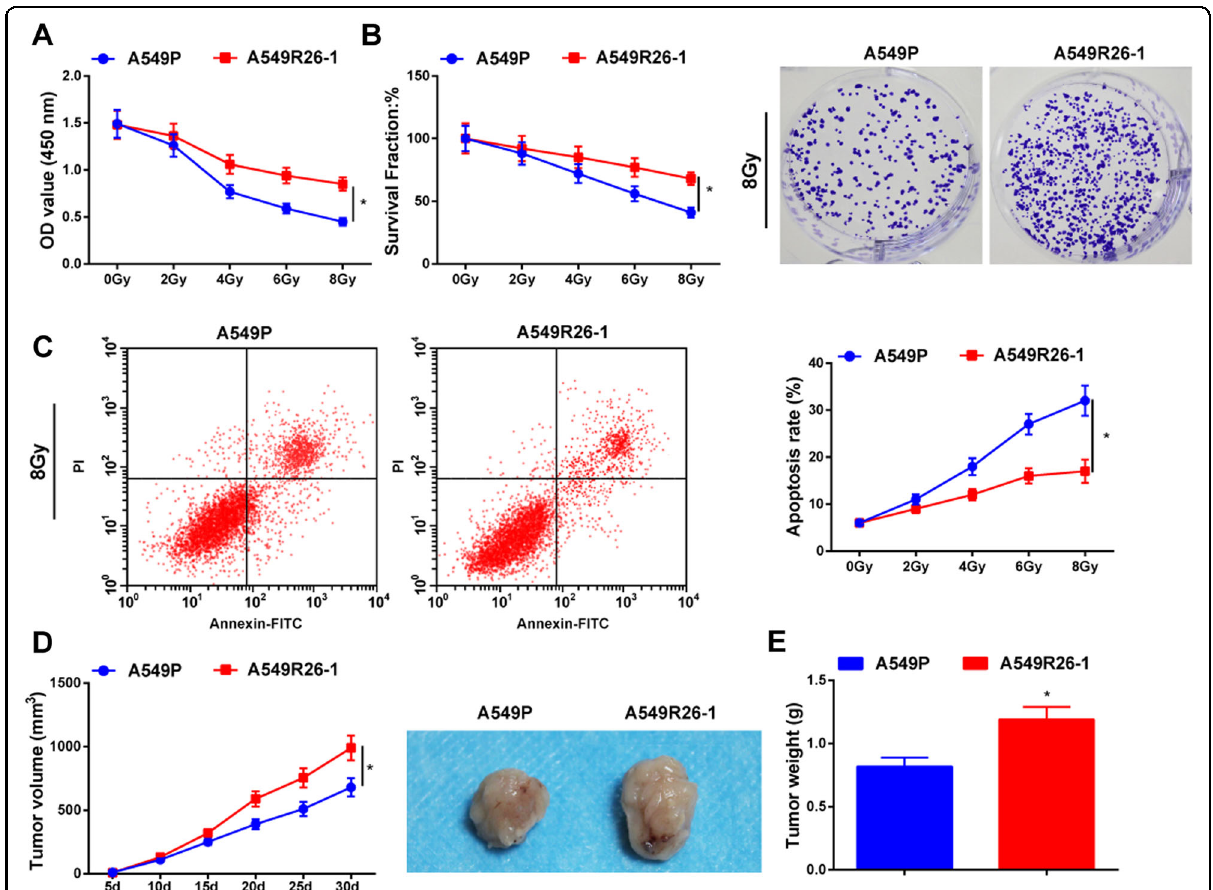
Fig. 2 Radioresistant lung cancer cells have stronger radioresistance ability than parent cells. A Viability of radioresistant lung cancer cells A549R26-1 and parental cells A549P was determined by CCK-8 assay. B Colony formation ability of radioresistant lung cancer cells A549R26-1 and parental cells A549P was detected by colony formation assay. C Apoptosis of radioresistant lung cancer cells A549R26-1 and parent cells A549P was detected by fl ow cytometry. D Volume of xenografts from nude mice that had been injected with radioresistant lung cancer cells A549R26-1 and parental cells A549P. E Weight of xenografts from nude mice that had been injected with radioresistant lung cancer cells A549R26-1 and parental cells A549P; N = 3 in the cellular experiment and n = 6 in the animal experiment; * P < 0.05 vs. A549P cells; the measurement data were expressed as mean ± standard deviation, one-way ANOVA was used for comparisons among multiple groups and Tukey ’ s post hoc test was used for pairwise comparisons after one-way